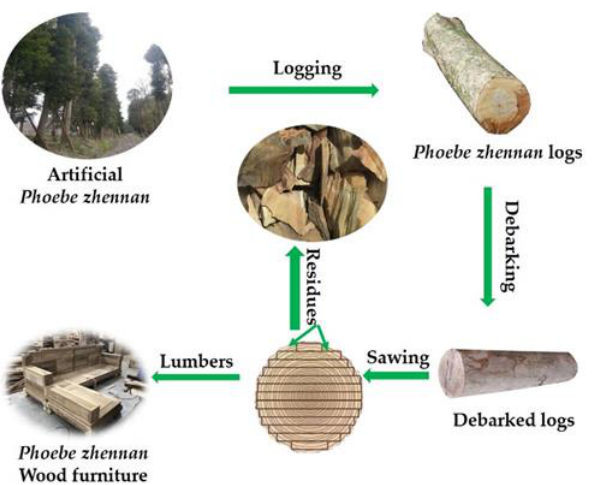
Figure 10. Flowchart of the saw milling process and the residue sample portions in the Phoebe zhennan wood.